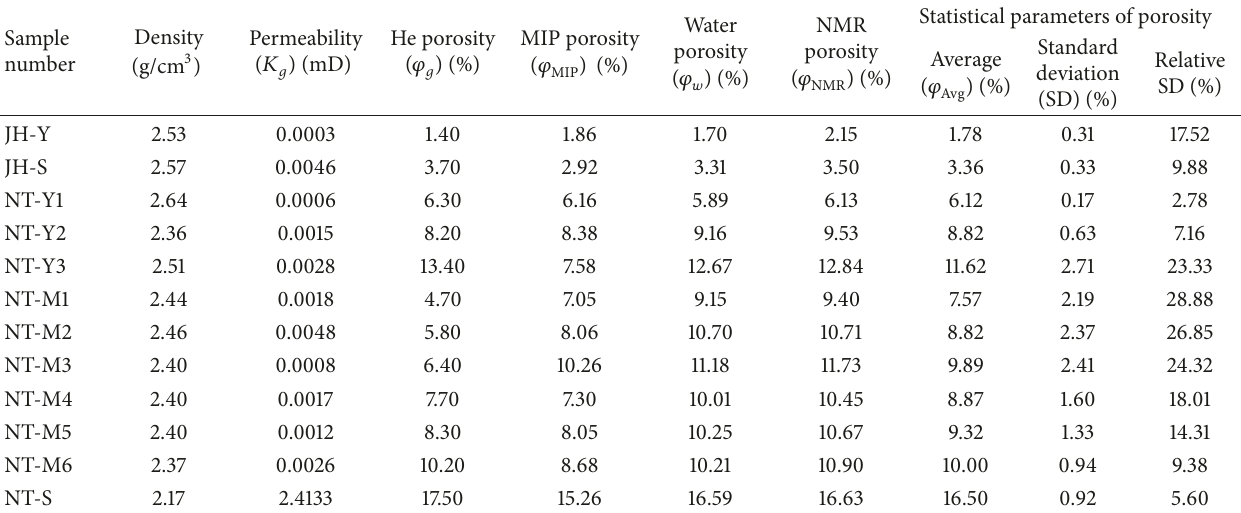
Table 3: Density, permeability, and porosities of the investigated rock samples.